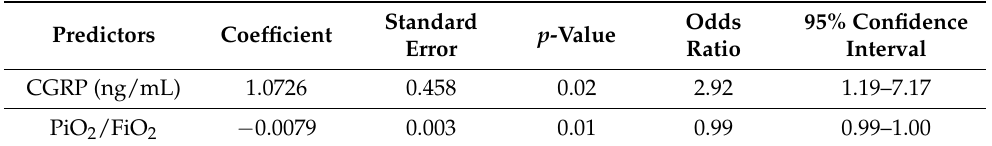
Table 8. Multivariate stepwise logistic regression of plasma CGRP levels at baseline (t0) predicting the development of pulmonary vascular complications, including demographic and disease severity variables. The variables entered in the model are reported in the table. Age, gender, and NEWS2 score did not enter the model.